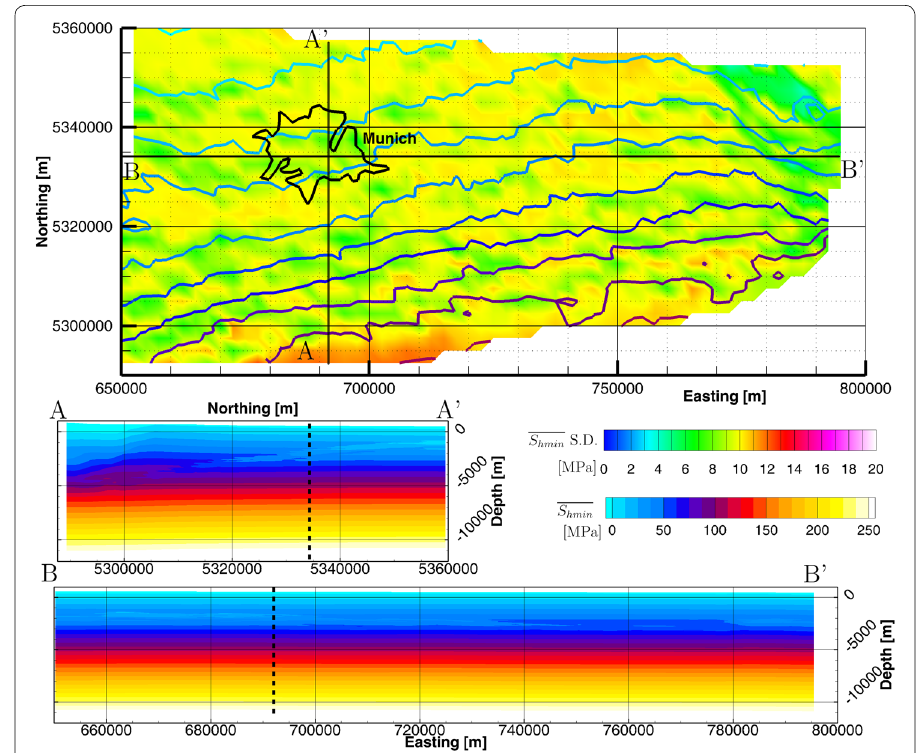
Fig. 4 Average stress magnitude and standard deviation of S hmin . Top: S hmin average magnitude in isolines and standard deviation in contour mapped on the top of Malm delta that is dipping towards the south. Thick black lines show the location of the NS and EW profiles A – A ′ and B – B ′ , respectively. Bottom: South–North ( A – A ′ ) and West–East ( B – B ′ ) profiles showing the average magnitude of S hmin with a vertical exaggeration of 1:2. The intersection of the profiles is indicated by the dotted